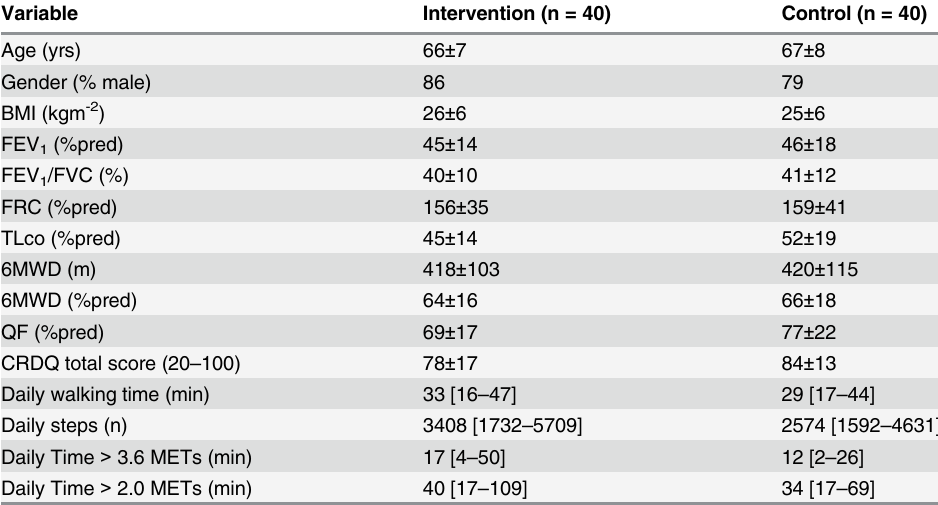
Table 1. Baseline